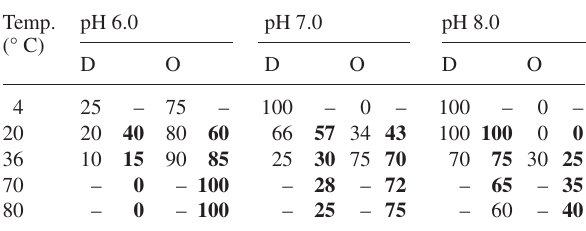
at pH 4.0 (101.6 and 97.3 °C, respectively). The finding that the Y41C mutant had the lowest T value is accounted for by m the presence of the additional cysteine residue. Table 2. Effects of pH and temperature on the percentage of dimeric (D) and octameric (O) species of the Sulfolobus solfataricus WT pro- tein as indicated by AUC and GPC (in bold). Experiments were per- formed in 20 mM sodium phosphate buffers. Samples for AUC were incubated in the rotor for 12 h at 4, 20, and 36 °C, those for GPC were incubated for 2 h at 70 and 80 °C and immediately injected onto the Superdex 200